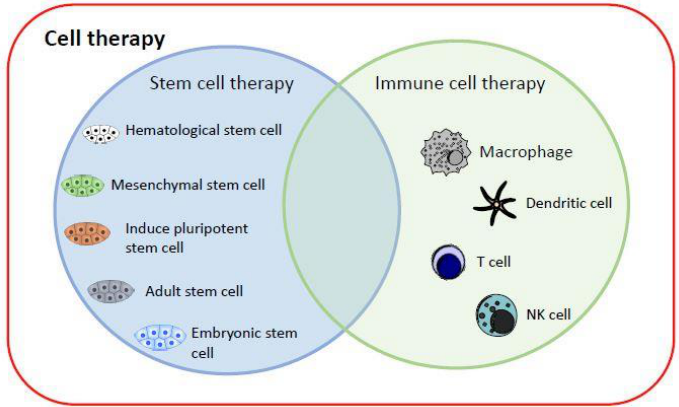
Figure 1. Current cell therapy categories. The major cell therapy categories include stem cell therapy and immune cell therapy. They can replace and repair damaged cells, tissues, and organs in humans, or kill target cells.